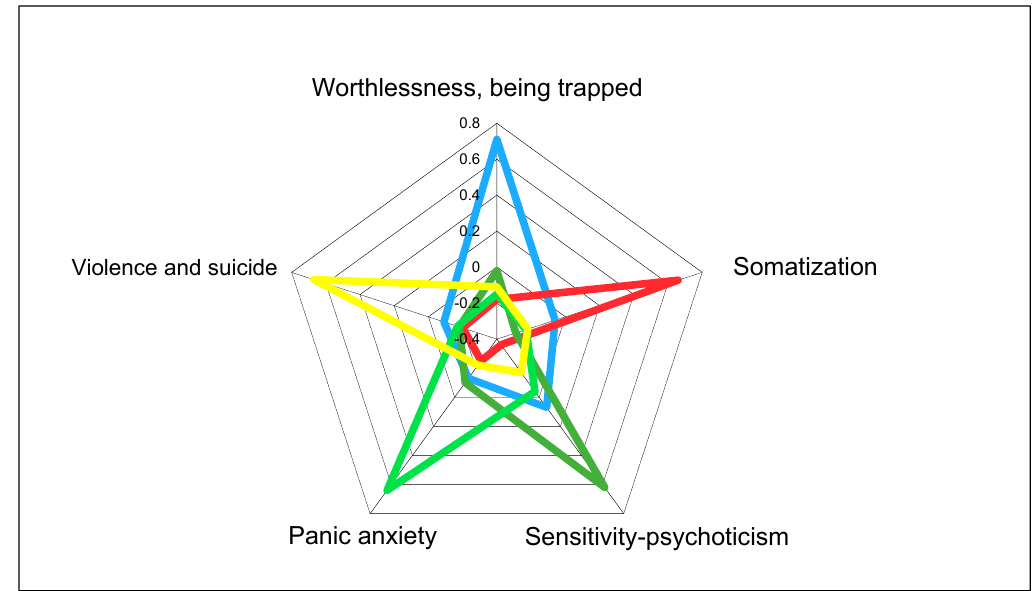
Figure 2. Independence of psychopathological dimensions identified by exploratory principal component factor analysis (PCA) applied to 1055 SCL-90 questionnaires answered by patients with opioid dependence at the onset of the treatment with opioid agonists: highest Z-scores obtained by patients on each dimension [14].